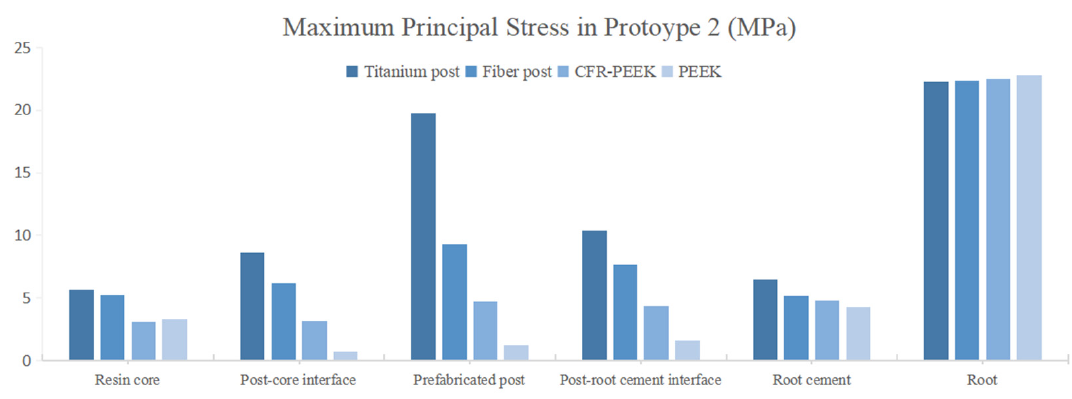
Figure 5. Peak value of MPS at post in Prototype 2.